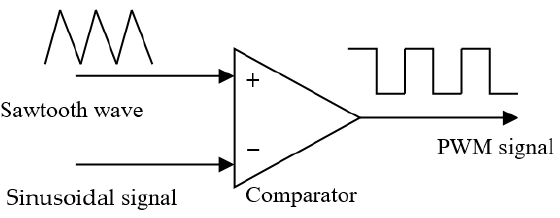
Figure 2. Generation of PWM signal.